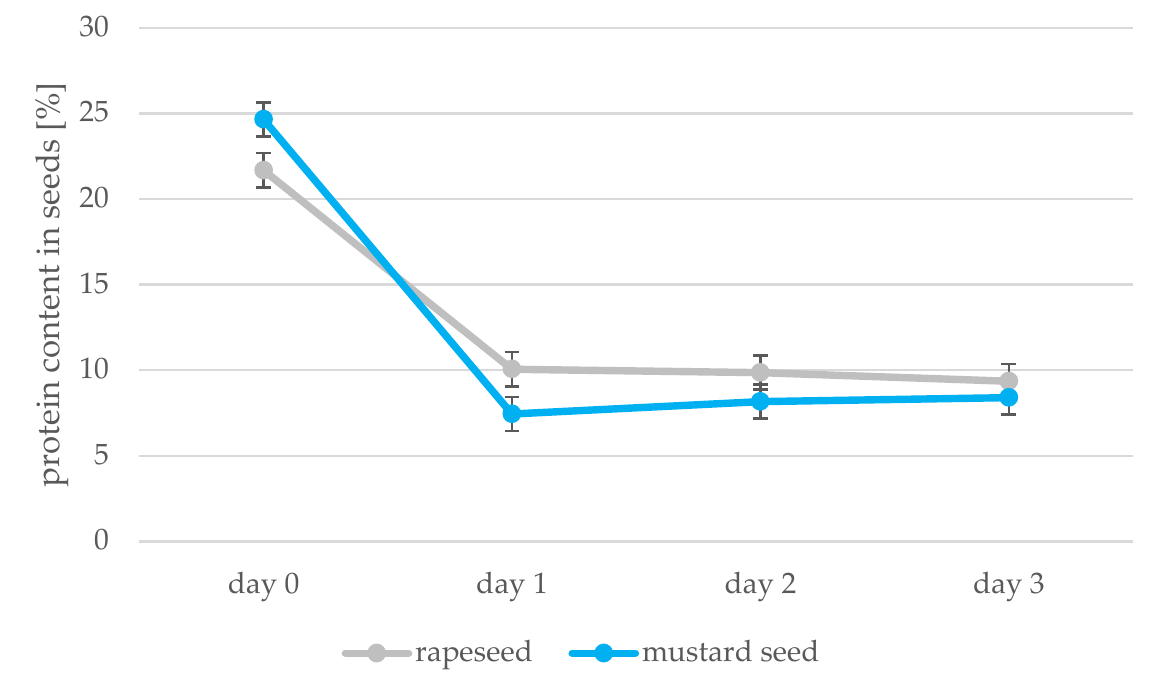
Figure 8. Peroxidase activity [ Δ OD/min/ μ g proteins] in rapeseeds and mustard seeds during ger ‐ mination (days 0, 1, 2, 3) (values are means ± SD from three experiments.). 3.7. Principal Component Analysis (PCA) Principal component analysis (PCA) was applied to observe possible clusters in oil samples obtained from rape and white mustard seeds. The first two principal factors ac ‐ counted for 81.5% (Dim1 = 55.9% and Dim2 = 25.6%) of the total variation. The PCA